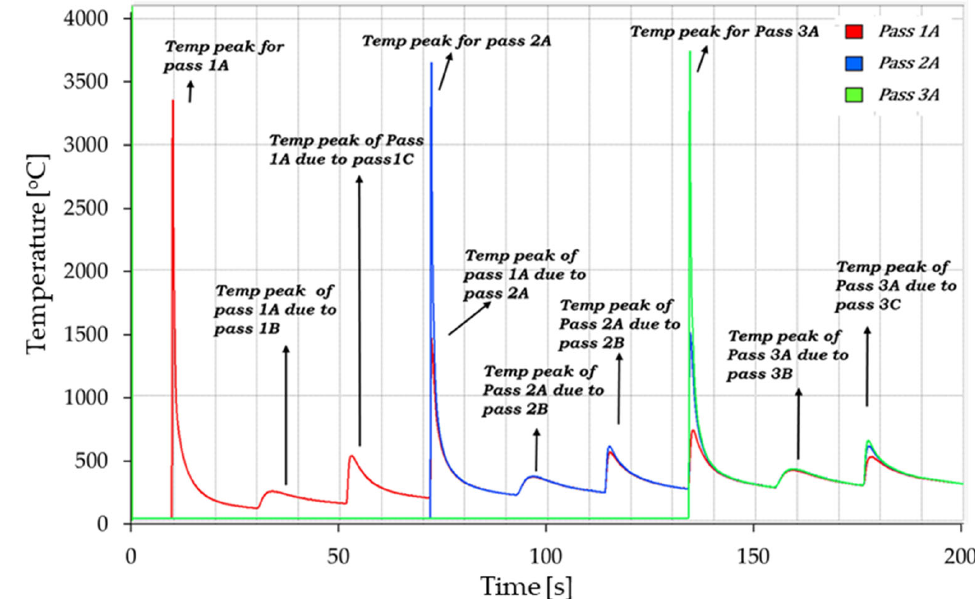
Figure 16. Thermal cycle variation for insulated substrate (A1) with the subsequent weld passes.